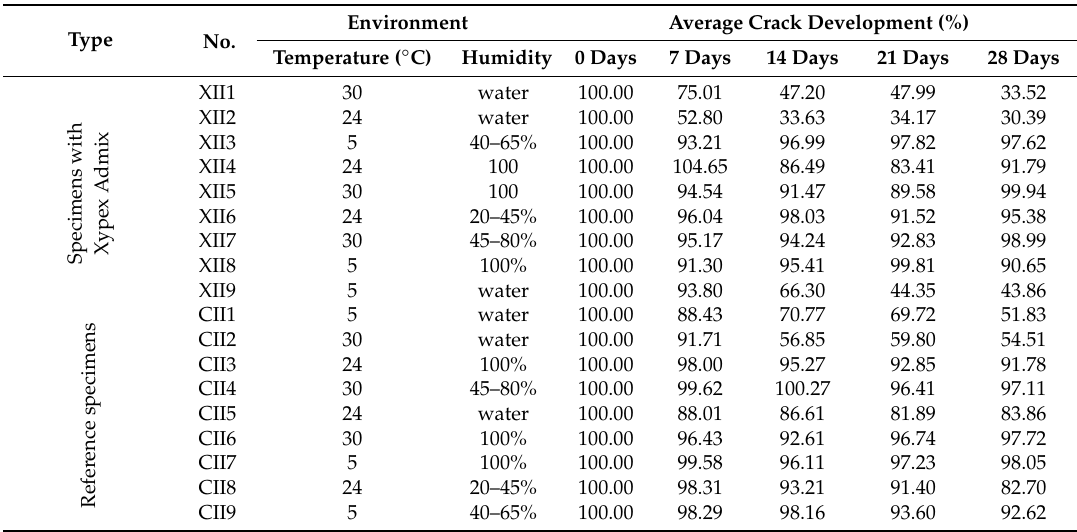
Table 8. Comparison of crack development—the first phase.